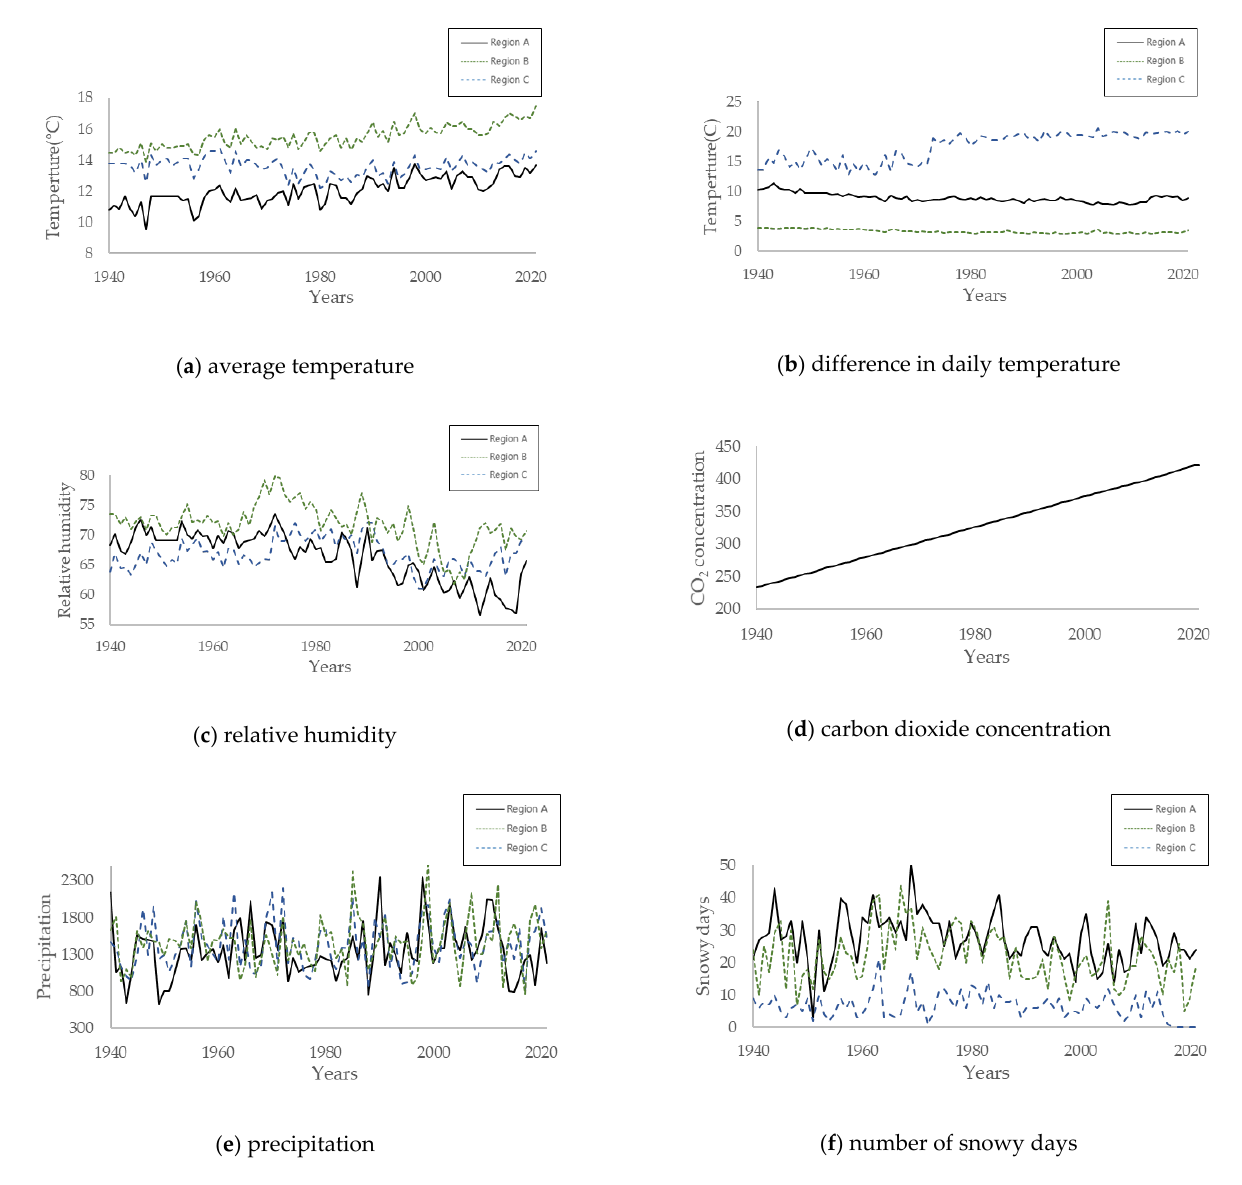
Figure 5. History of environmental conditions according to regions: ( a ) average temperature; ( b ) difference in daily temperature; ( c ) relative humidity; ( d ) carbon dioxide concentration; ( e ) precipitation; and ( f ) number of snowy days.